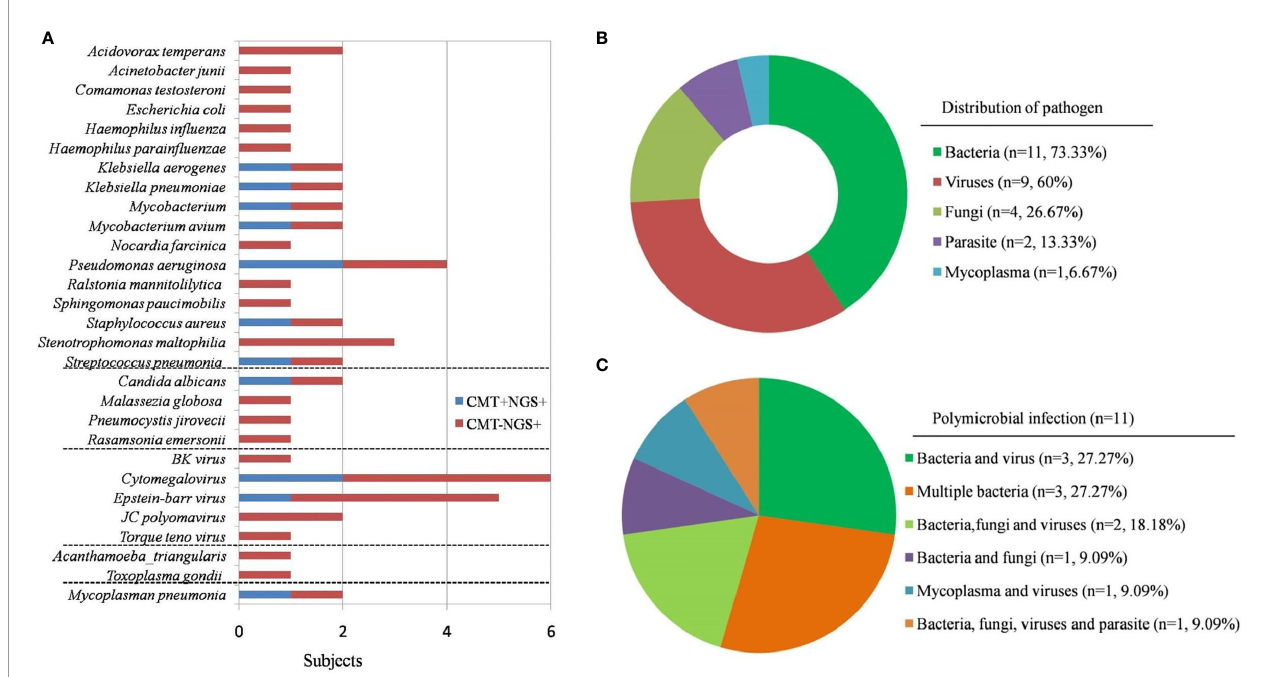
FIGURE 3 | Pathogens identi fi ed in PID patients using CMT and NGS. (A) The fi gure shows the number of subjects in whom each microbe was detected. Blue bars indicate microbes detected by CMT and predicted to be pathogens by NGS (CMT+NGS+). Red bars indicate microbes detected by NGS only (CMT − NGS+). (B) Distribution of pathogens in patients with PID. (C) Polymicrobial infection accounted for 73.33% of cases; different kinds of polymicrobial infection are shown.